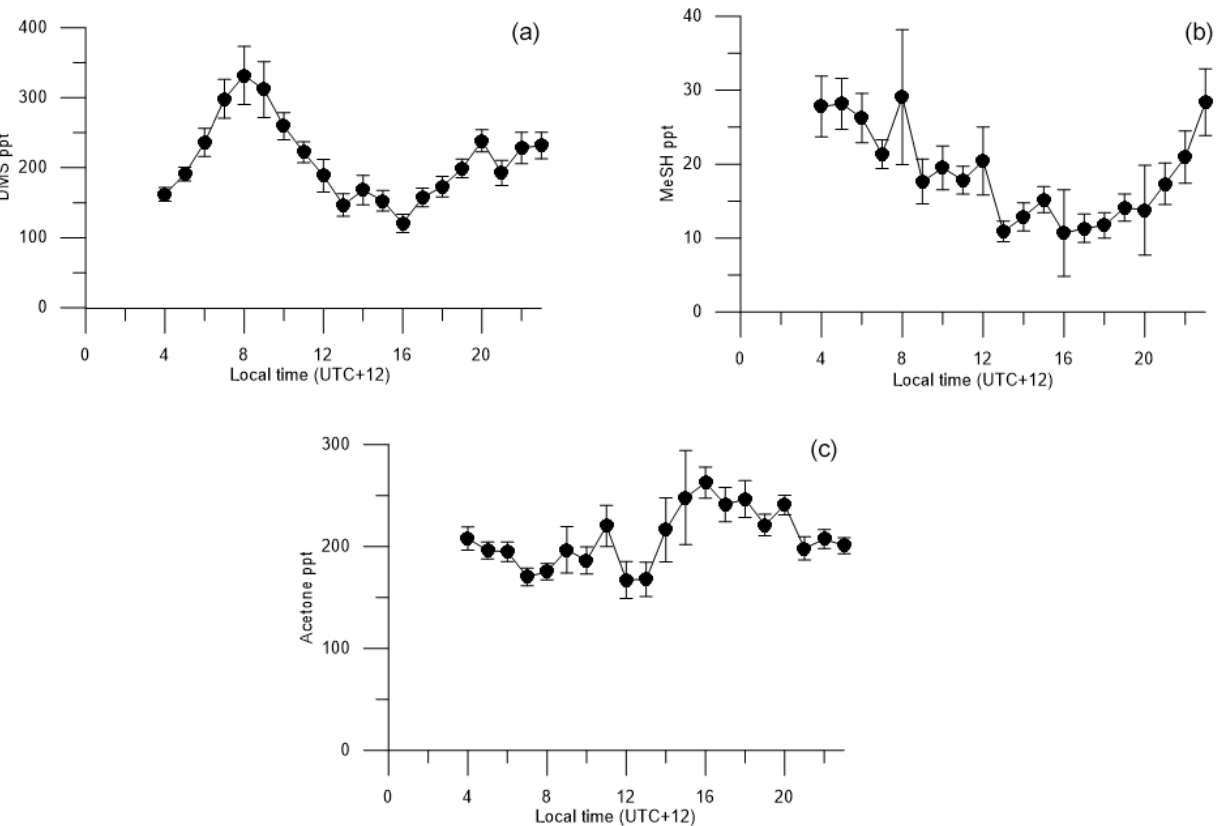
Figure 6. Diurnal cycles of (a) DMS a , (b) MeSH a , (c) acetone a with land-influenced data removed. Average values from 00:00 to 03:00 are excluded because of lower data collection during this period, due to calibrations and zero air